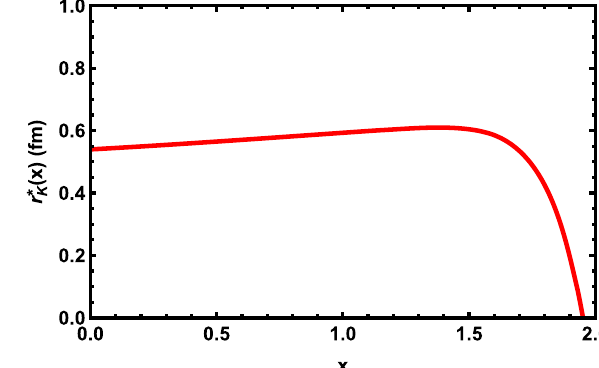
Fig. 11 The variation of F ∗ medium at different values of Q 2